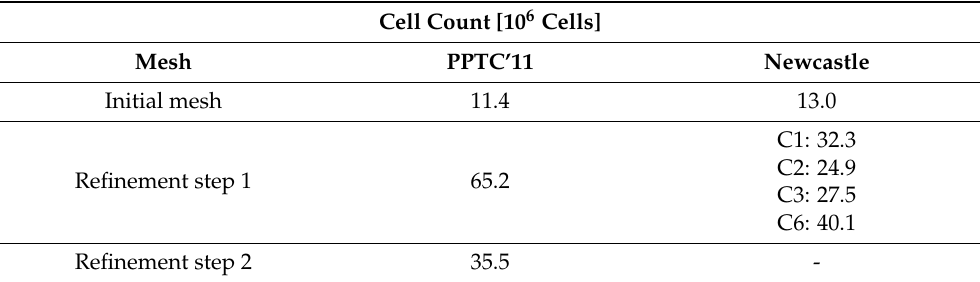
Figure 3. PPTC’11. Distance refinement in tip vortex region: ( a ) first mesh refinement step based on Q -criterion Q = 5 · 10 4 s − 2 ; ( b ) second mesh refinement step based on α = 0.5 with additional hub vortex refinement. Table 5. Overview of the meshes for each case with applied refinement